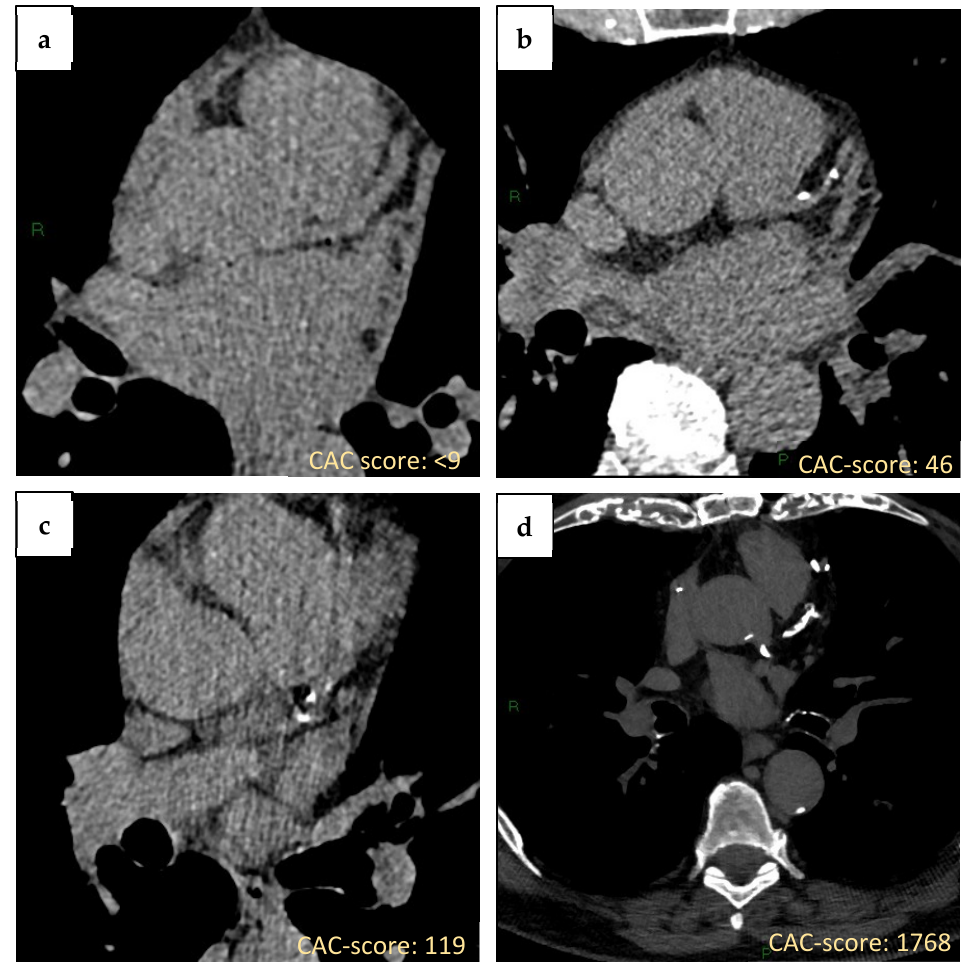
Figure 4. Coronary artery calcium (CAC) score assessment through cardiac computed tomography (CCT) stratified for risk category: ( a ) minimal risk, CAC score <9; ( b ) mild risk, CAC score 46; ( c ) moderate risk, CAC score 119; ( d ) severe risk, CAC score 1768.